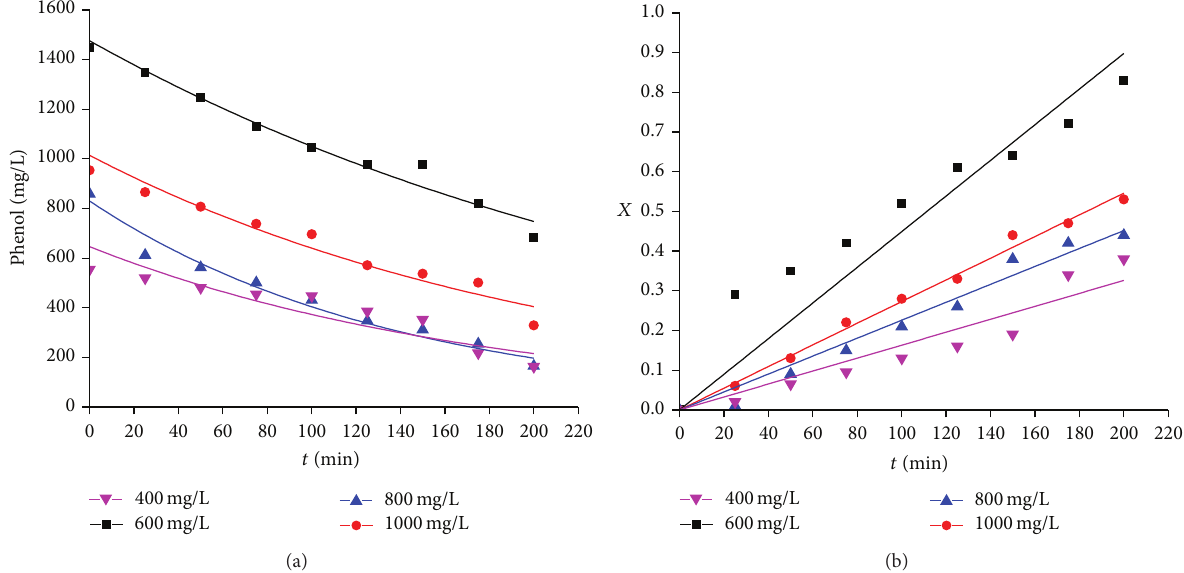
Figure 4: Variation of phenol concentration in different initial concentration of wastewater over time. (a) Variation of remaining phenol concentration over time. (b) Removal rate of phenol over time.